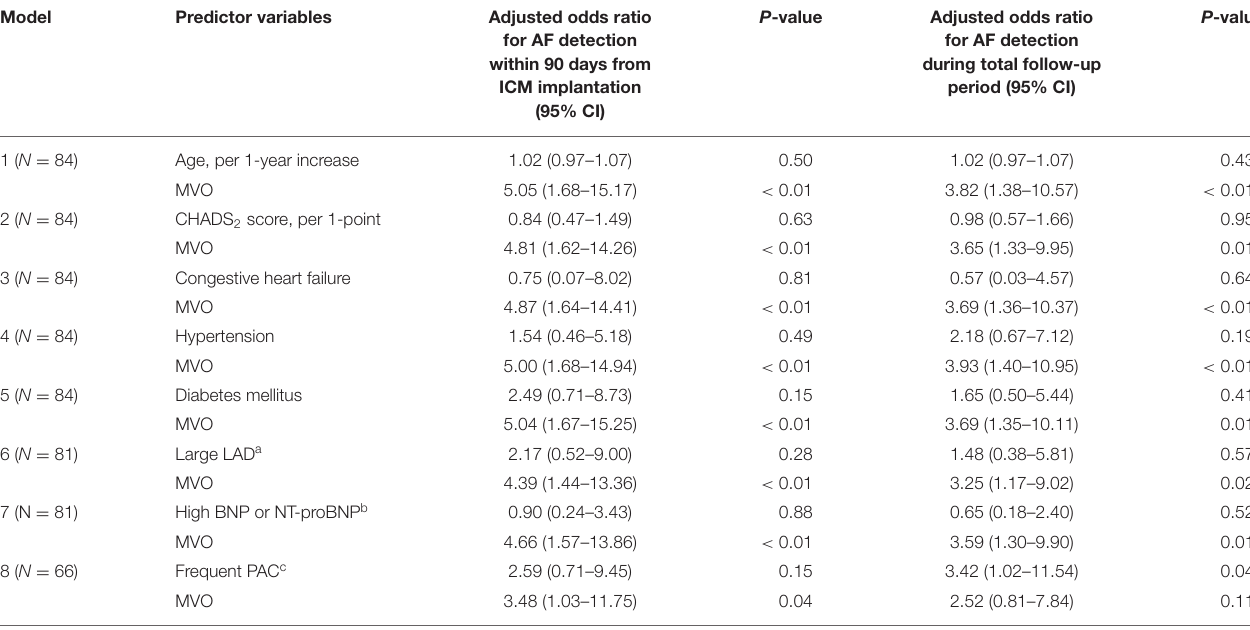
TABLE 2 | Odds ratios for atrial fibrillation detection.